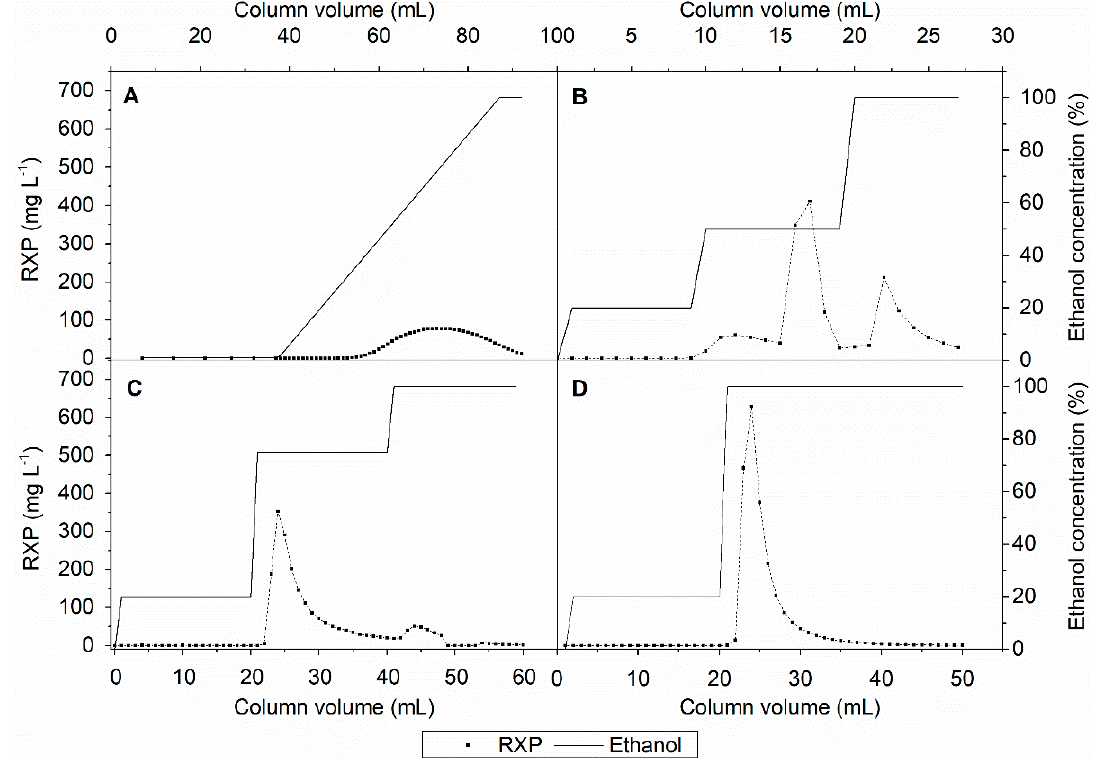
Figure 5. Intermediate purification of the RXP. ( A ) Elution profile of a linear ethanol gradient. ( B ) Elution profile of a step gradient with 20%, 50% and 100% ethanol. ( C ) Elution profile of a step gradient with 20%, 75% and 100% ethanol. ( D ) Elution profile of a step gradient with 20% and 100% ethanol.